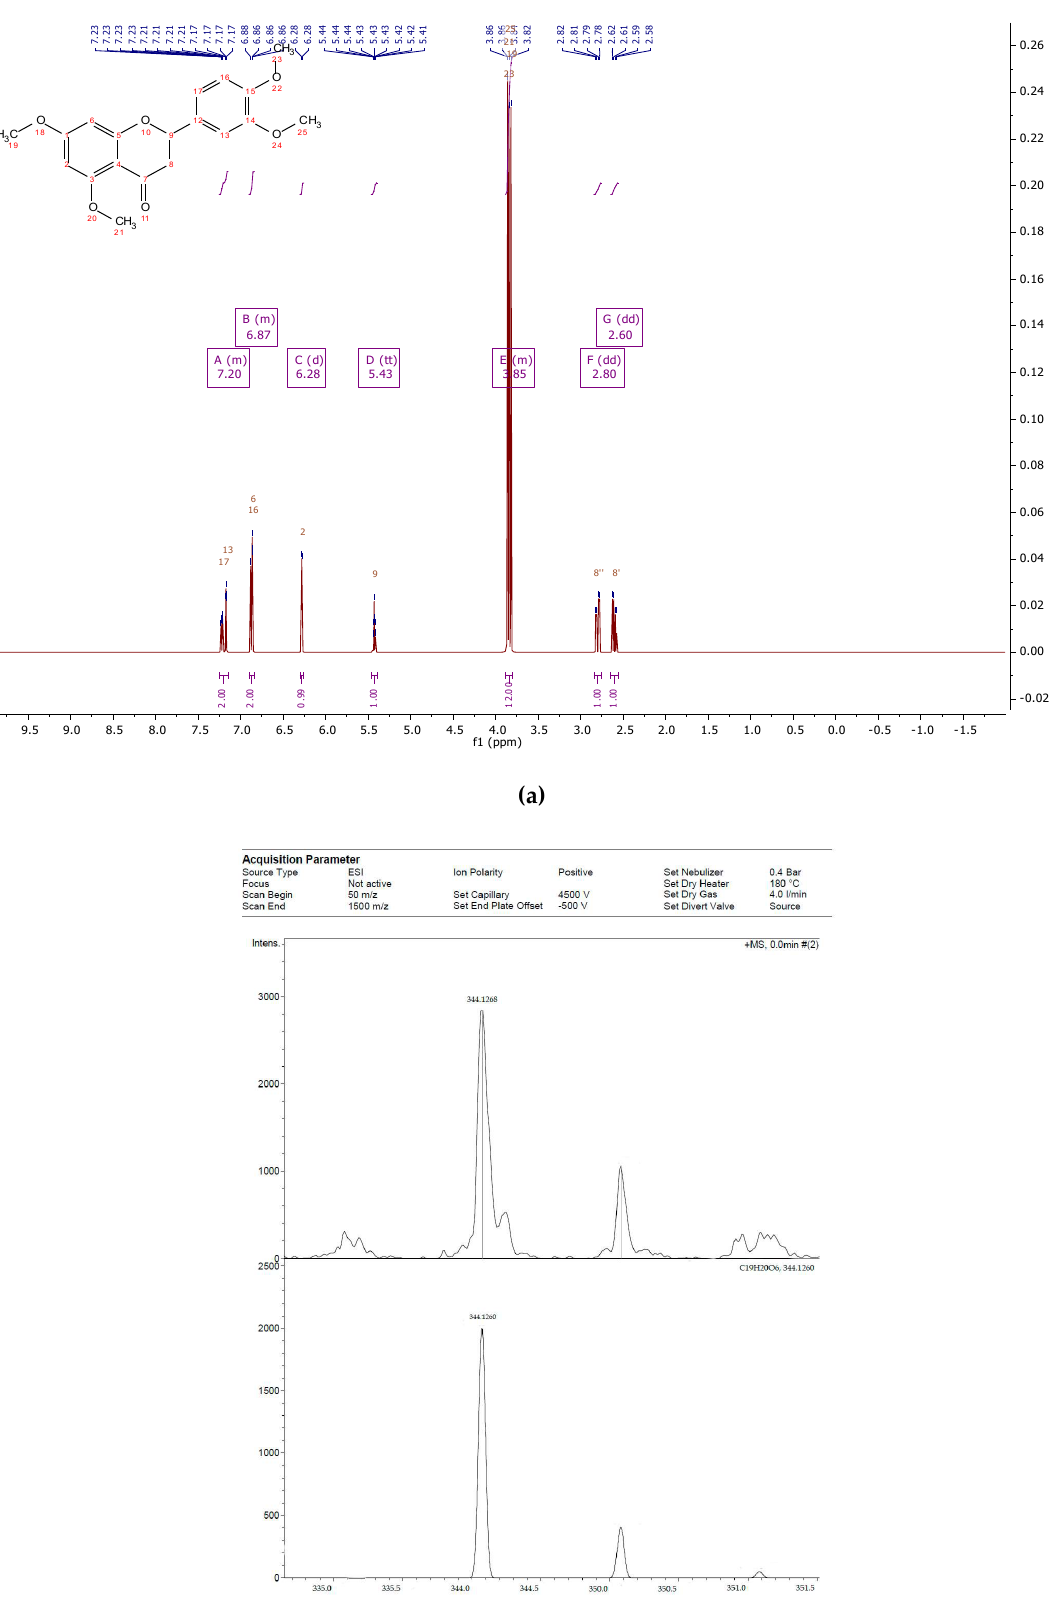
Figure 4. 1 H NMR ( a ) nd HRMS ( b ) spectrum of 2-(3,4-dimethoxyphenyl)-5,7-dimethoxychroman-4-one from extracts of callus, cell suspension, and root cultures of Rhodiola rosea